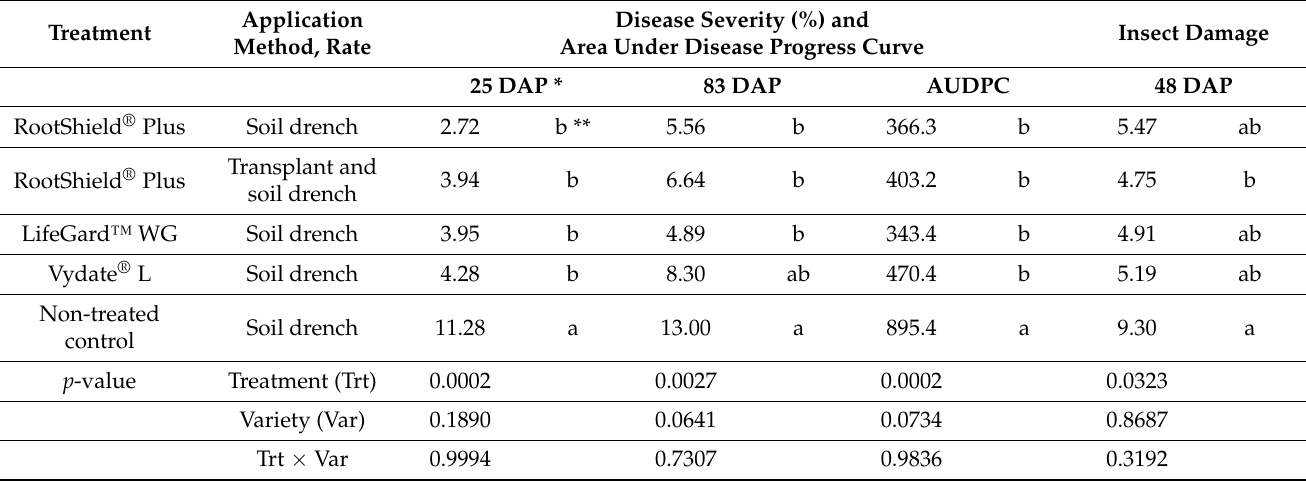
Table 2. Efficacy of biocontrol products and chemicals transplanted and soil-drenched in the study to mitigate seed- and diseases on ginger grown in the high tunnel in